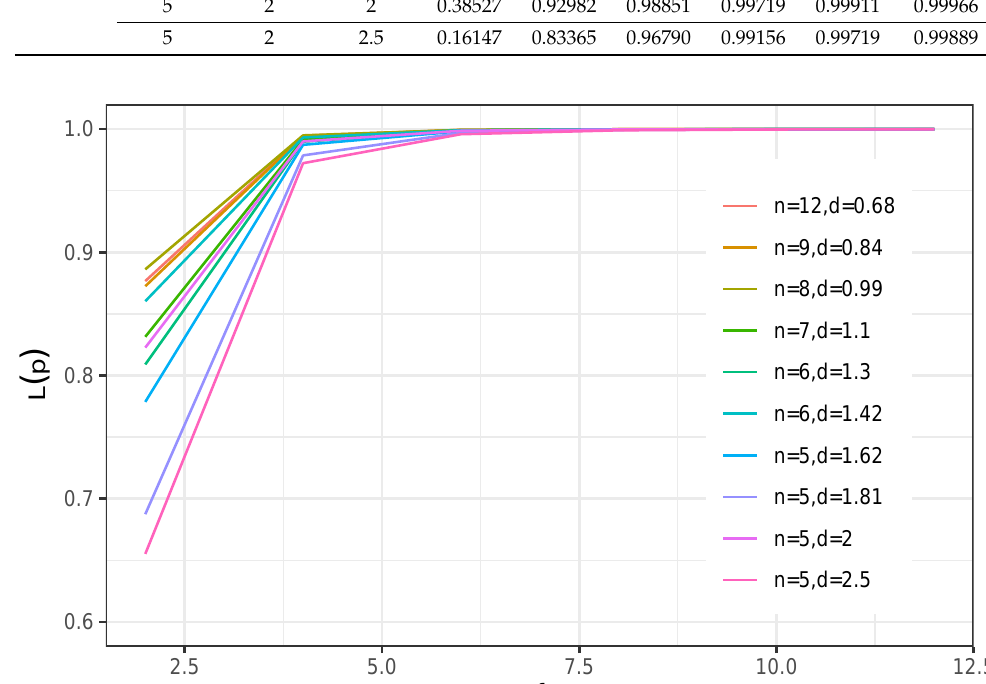
(cid:0) (cid:1) n , c , t λ